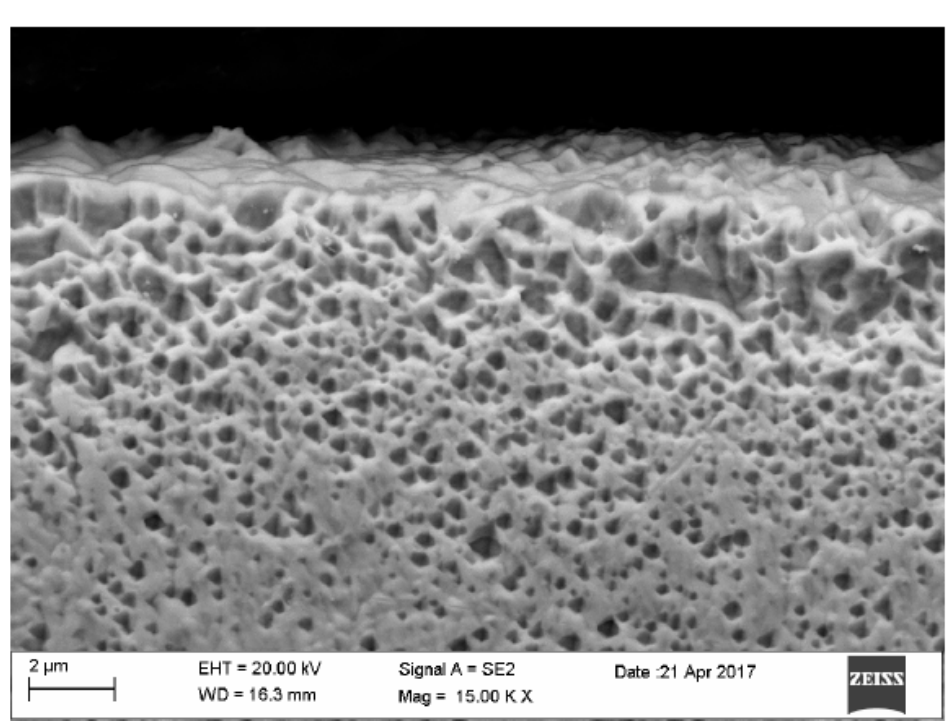
Figure 10. Surface of gold electrode.